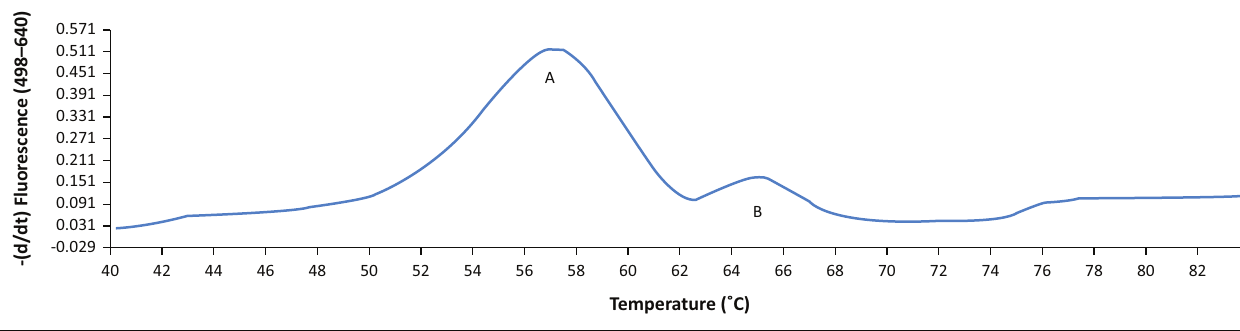
– peak B (65.3 °C) detected in the same run. 2